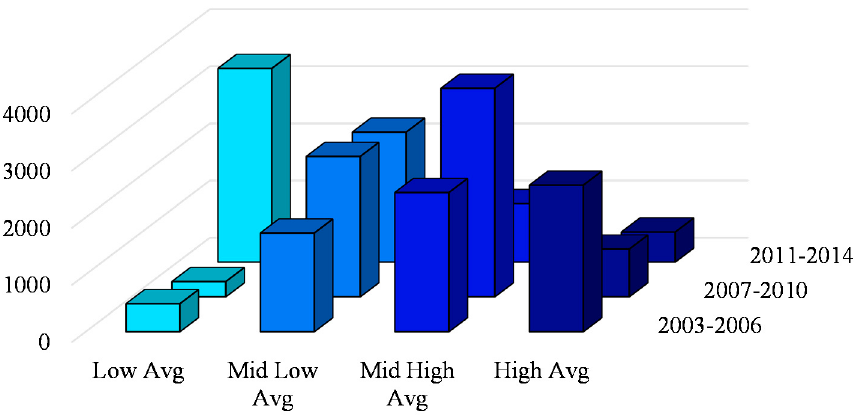
Figure 6. Distribution and categorization of normalized groundwater levels in Texas in 2003–2014. Source: Authors’ calculations and visualization.